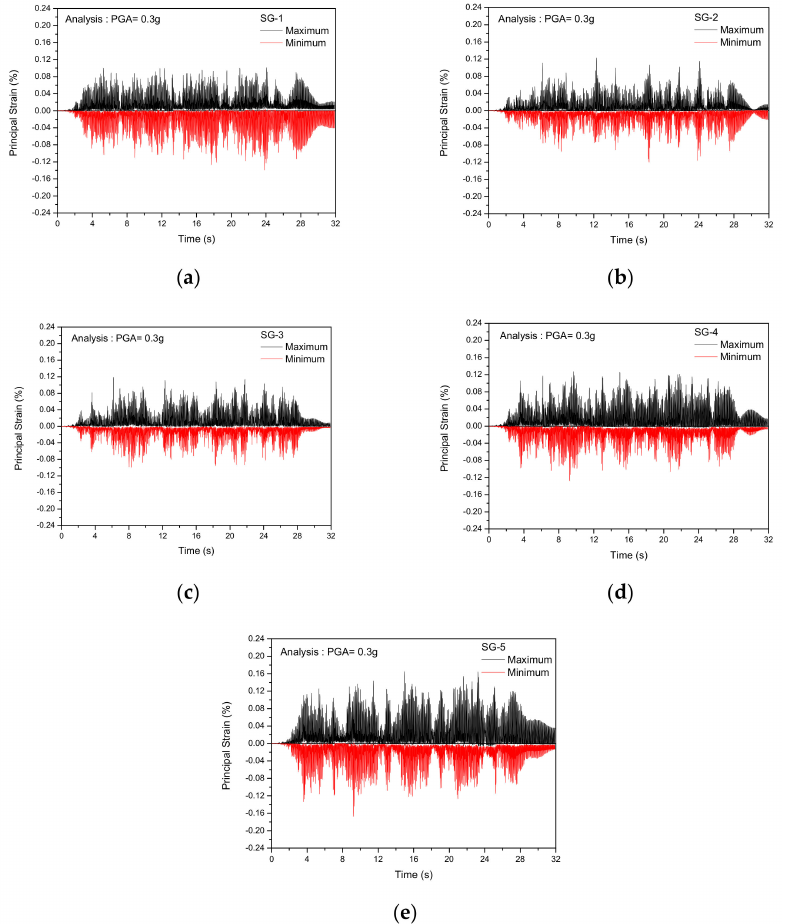
Figure 19. Inelastic seismic analysis results of principal strain time history responses for PGA = 0.3 g: ( a ) SG-1; ( b ) SG-2; ( c ) SG-3; ( d ) SG-4; ( e )